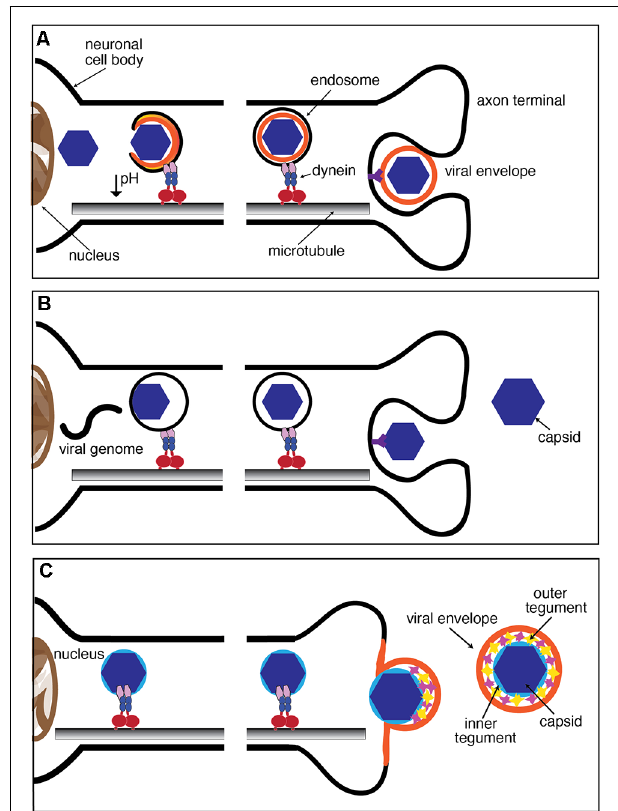
FIGURE 2 | Mechanisms of neuronal entry by viruses. (A,B) Both enveloped and non-enveloped viruses can be internalized through the endocytic pathway following receptor binding. Endosomes are transported from the axon terminal region to the soma as part of the endogenous FAT pathway. Release of the virion from the endosome occurs after or during retrograde axonal transport and in some cases can be triggered by a decrease in pH at the endosomal lumen. (C) Enveloped viruses, including alphaherpesviruses, can fuse with the plasma membrane, resulting in the release of the capsid and tegument proteins to the cytoplasm. This fusion event results in the loss of the viral envelope prior to transport to the nucleus. Once internalized, cytoplasmic virions may directly recruit components of the dynein motor complex or associate with endogenous host organelles to engage in retrograde axonal transport to the